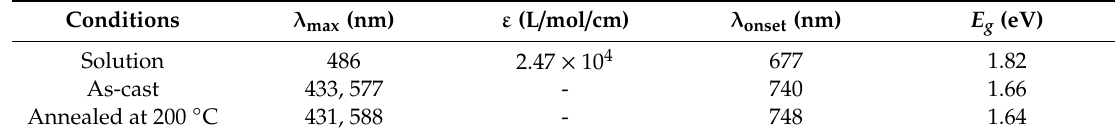
Figure 2. UV-vis absorption spectra of POTV ( a ) in chloroform and ( b ) in the films drop-cast from Table 2. Optical parameters of POTV. chloroform and annealed at 200 °C at 10 min. Table 2. Optical parameters of POTV.